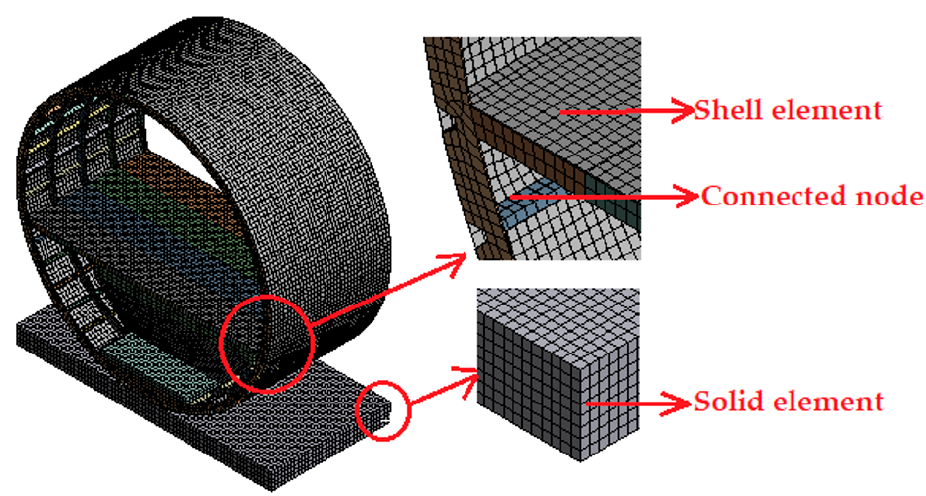
Figure 2. Mesh generation on fuselage section .